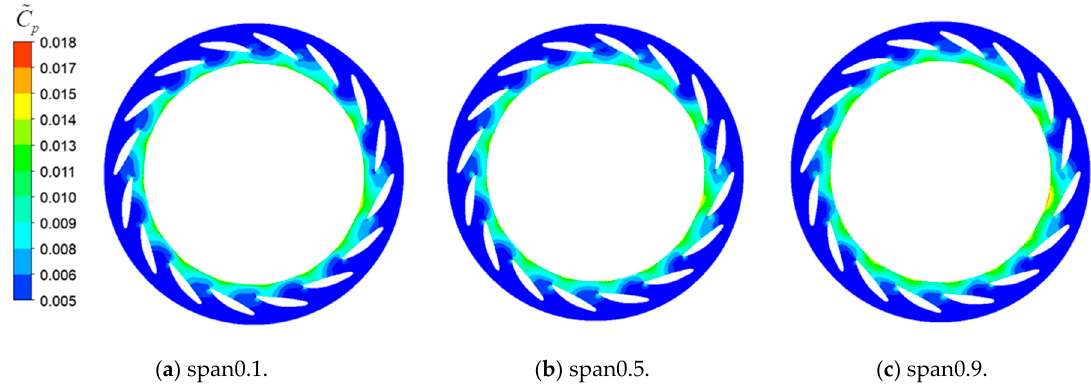
Figure 18. Pressure fluctuation distributions at different vane heights at 1.0 Q d .